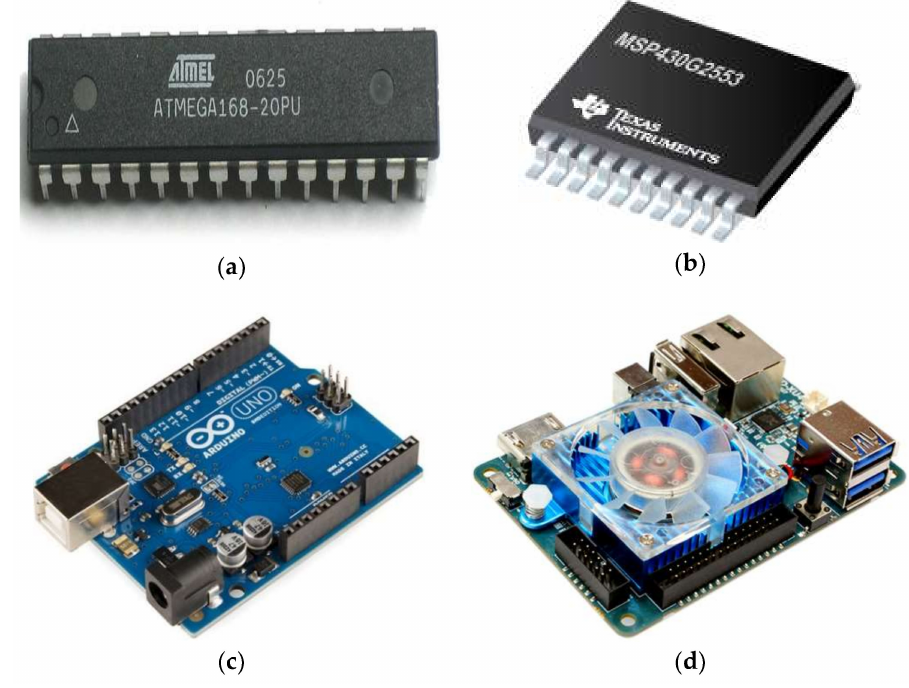
Figure 13. ( a ) ATmega microcontroller, ( b ) MSP430G2553 microcontroller, ( c ) Arduino Uno board, and ( d ) Odroid XU4